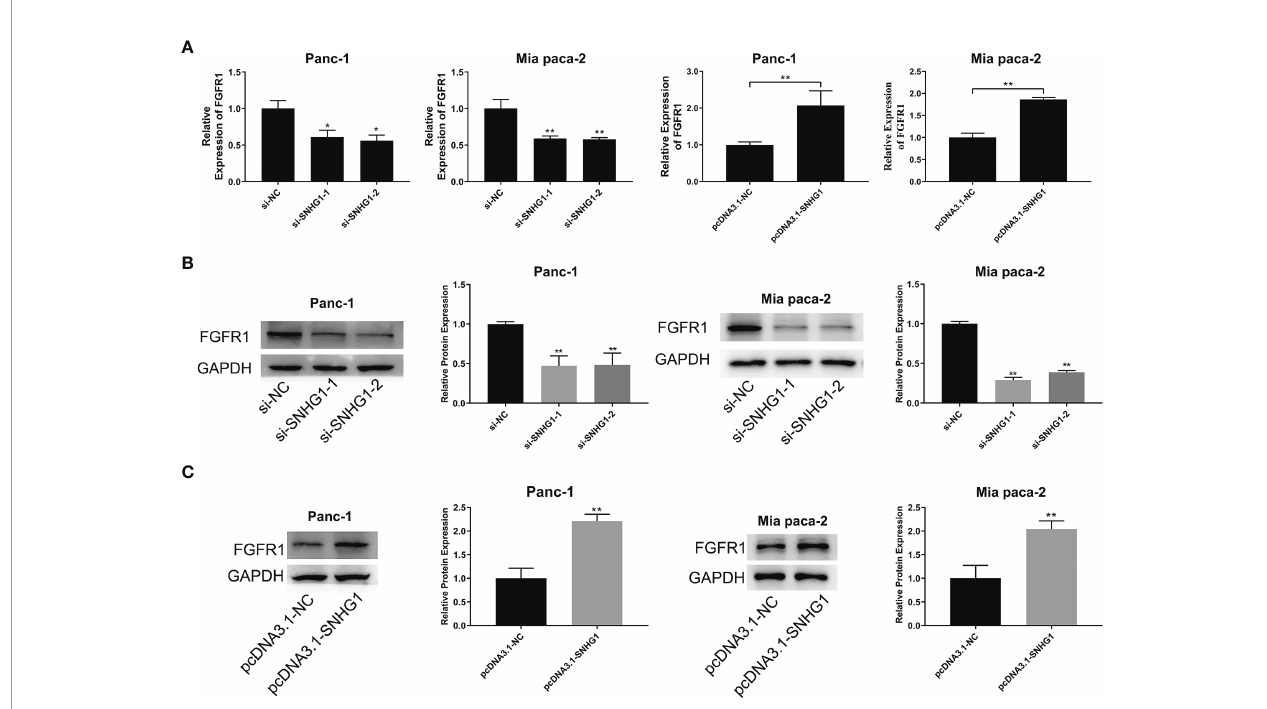
FIGURE 8 | SNHG1 acts as a ceRNA to regulate FGFR1 expression. (A) qRT-PCR quanti fi cation of FGFR1 expression after silencing or overexpression of SNHG1. (B, C) WB showed FGFR1 protein levels after si-SNHG1 or pcDNA3.1-SNHG1 transfection. *p < 0.05, **p <